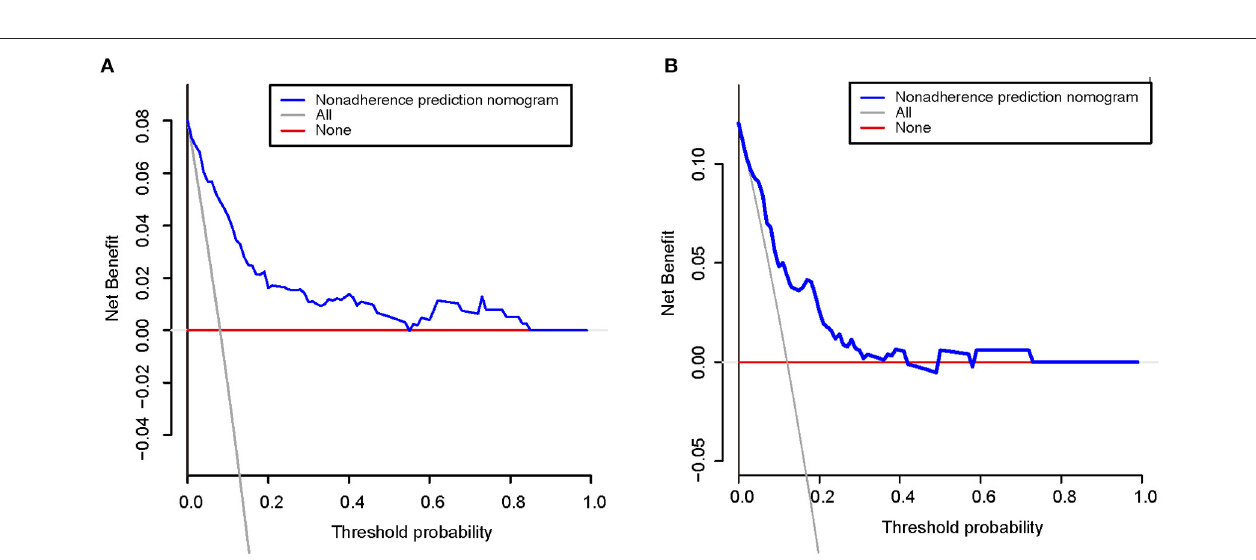
FIGURE 5 | Calibration curve of the nomogram for the training set (A) and the testing set (B) . Training set: B = 1,000 repetitions, boot, mean absolute error = 0.025, n = 387; testing set: B = 1,000 repetitions, boot, mean absolute error = 0.026, n = 166.